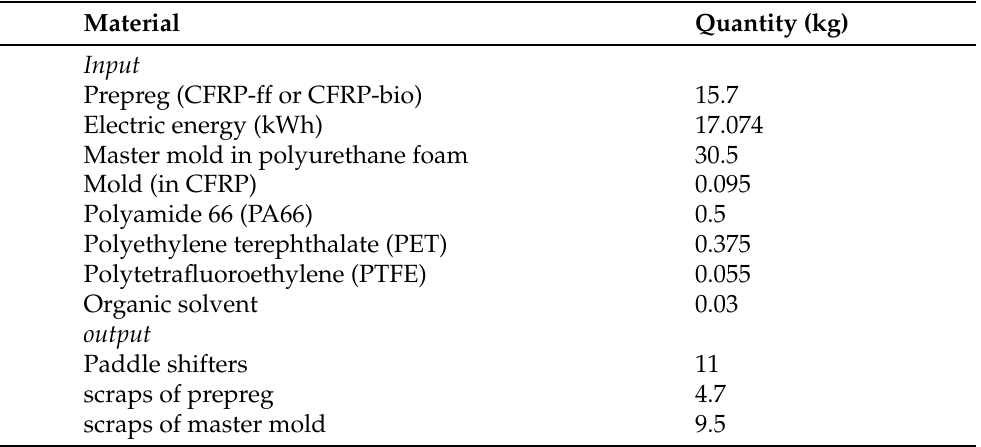
Table 6. Inventory data for the manufacturing of the paddle shifters taken from Forcellese et al.